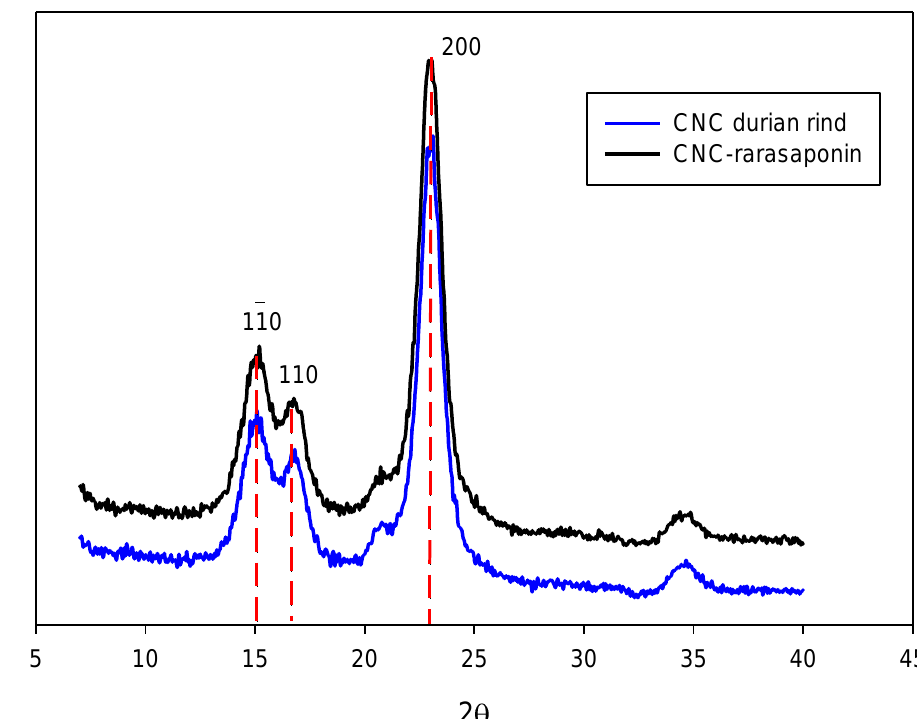
Figure 4. XRD spectra of CNCs durian rind and CNCs-rarasaponin.